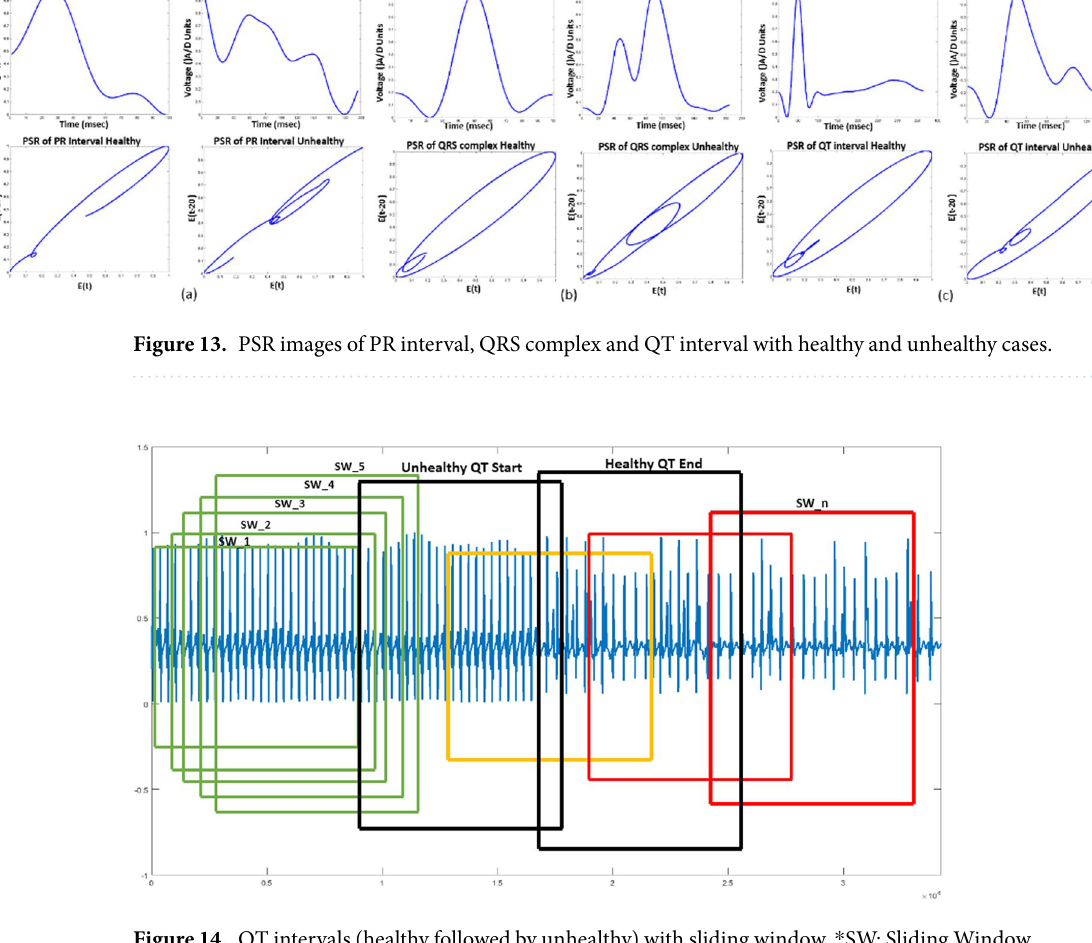
Figure 14. QT intervals (healthy followed by unhealthy) with sliding window. * SW: Sliding Window (Occupying 20 QT intervals), Green Window: Healthy QT interval, orange window: Healthy + Unhealthy QT intetrval, Red: Unhealthy QT